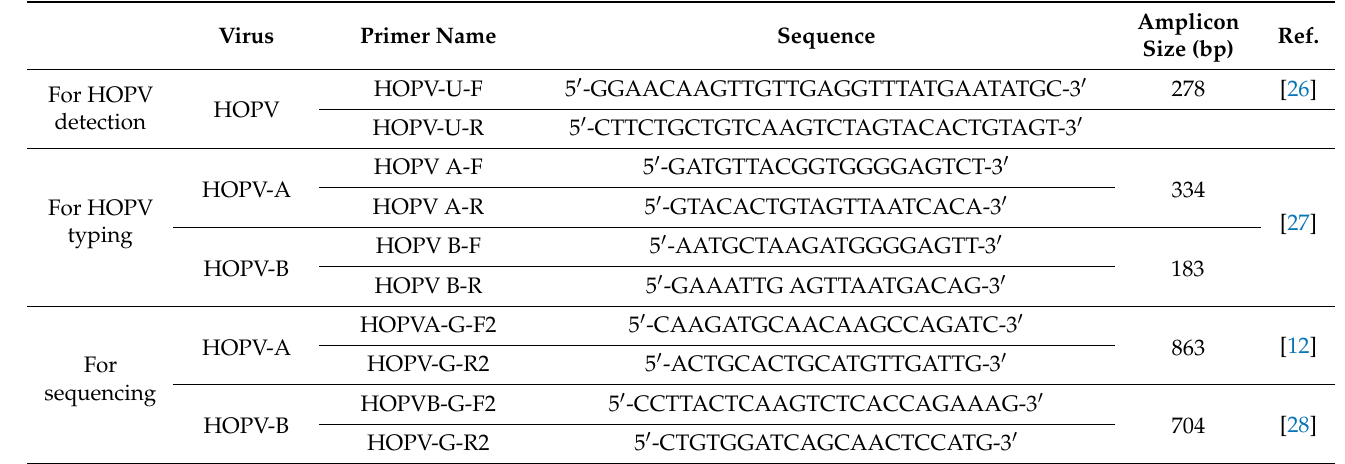
Table 1. List of HOPV primers used in this